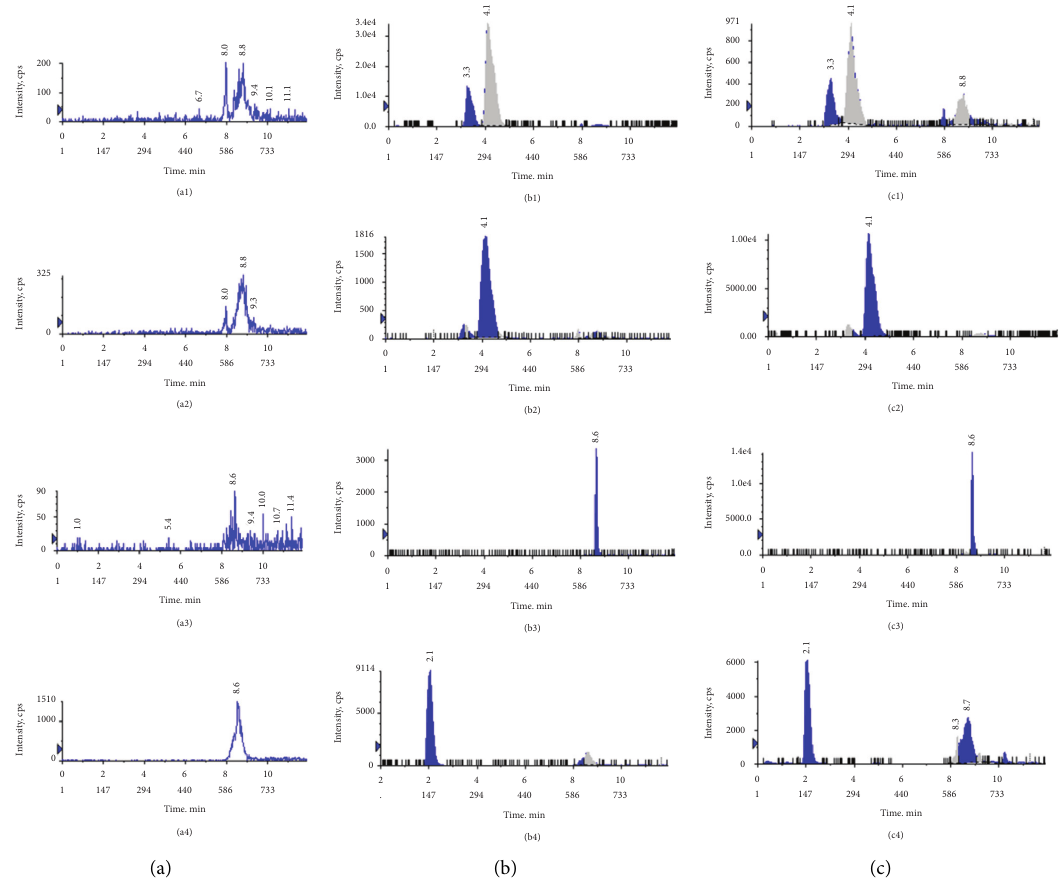
Figure 4: Representative chromatograms of narirutin (1), naringin (2), honokiol (3), and IS (4) in negative ionization mode in blank plasma (a), blank plasma sample spiked with the analytes (b), and plasma sample from a normal rat 1h after oral administration of ZZHPD